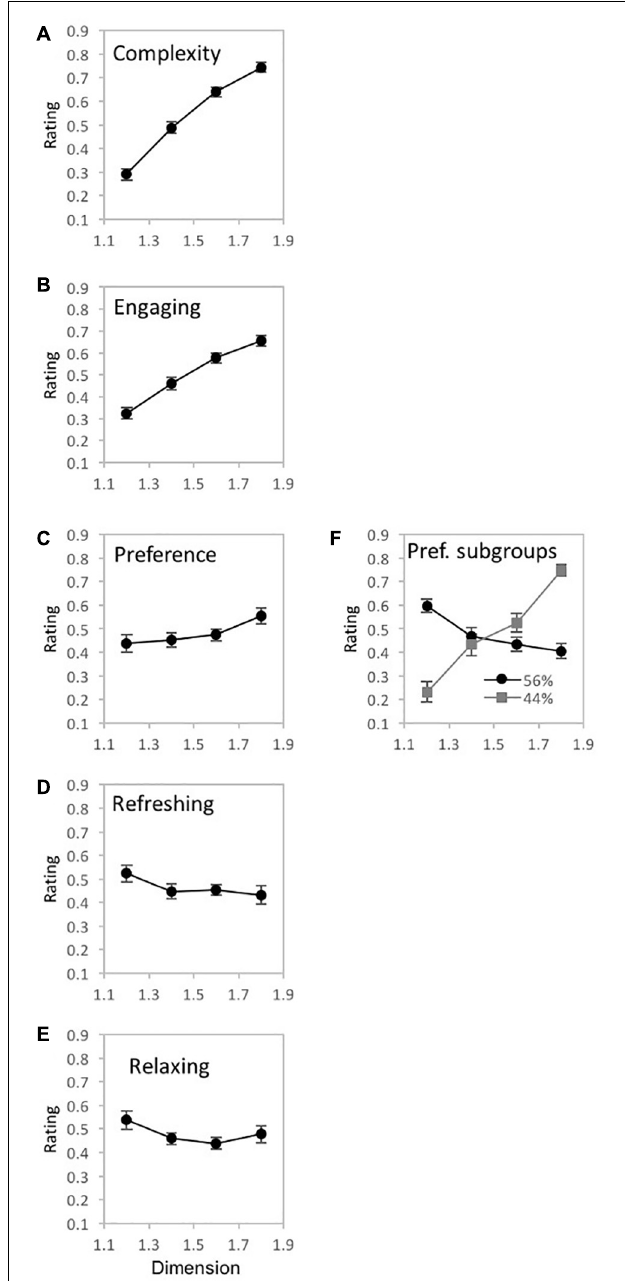
FIGURE 11 | Experiment 2 results for ‘tree-seed’ fractal patterns for 5 different judgment conditions (how complex, engaging, preferred, refreshing, and relaxing). (A–E) shows plots of mean ratings as a function of fractal dimension ( D ) for the different judgment conditions (error bars represent standard error). (F) shows a plot of the mean ratings as a function of fractal dimension ( D ) for each subpopulation identified with cluster analysis (error bars represent standard